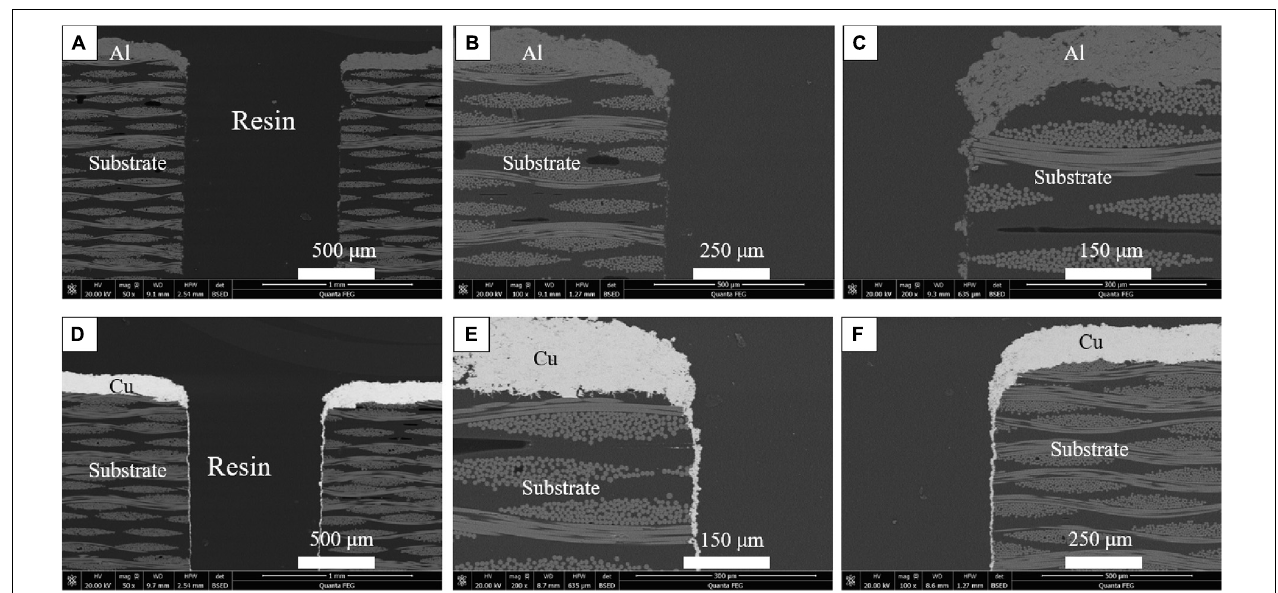
FIGURE 14 | SEM cross-section macrographs around hole after HVOF spraying: (A–C) Al coating and (D–F) Cu coating.